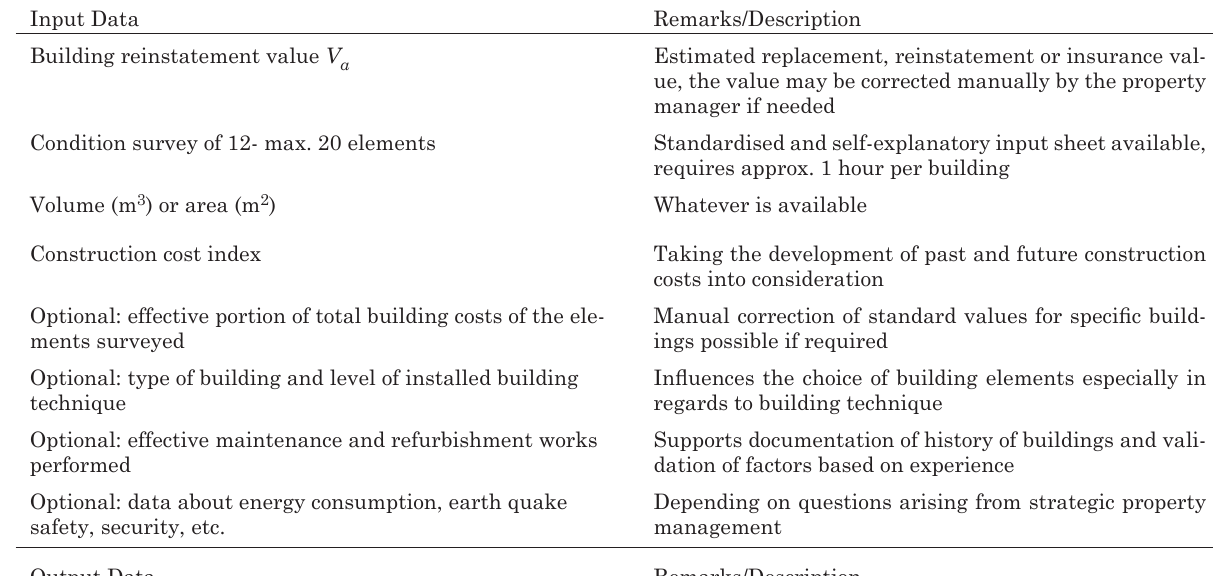
Table 1. Required Input and calculated output from the instrument Stratus/Spectus based on the method